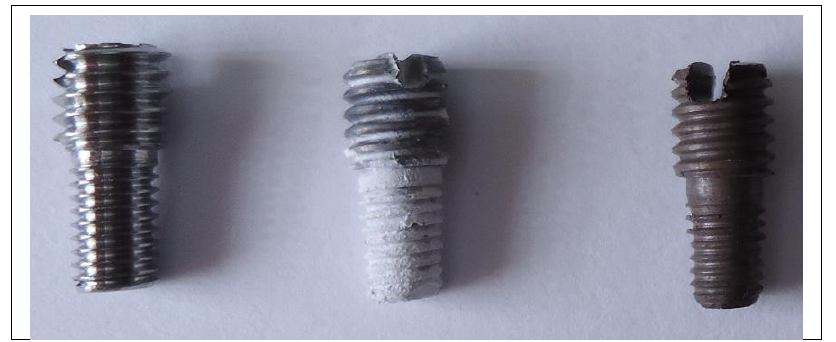
Figure 1: From left: Untreated, Coated with ZrO